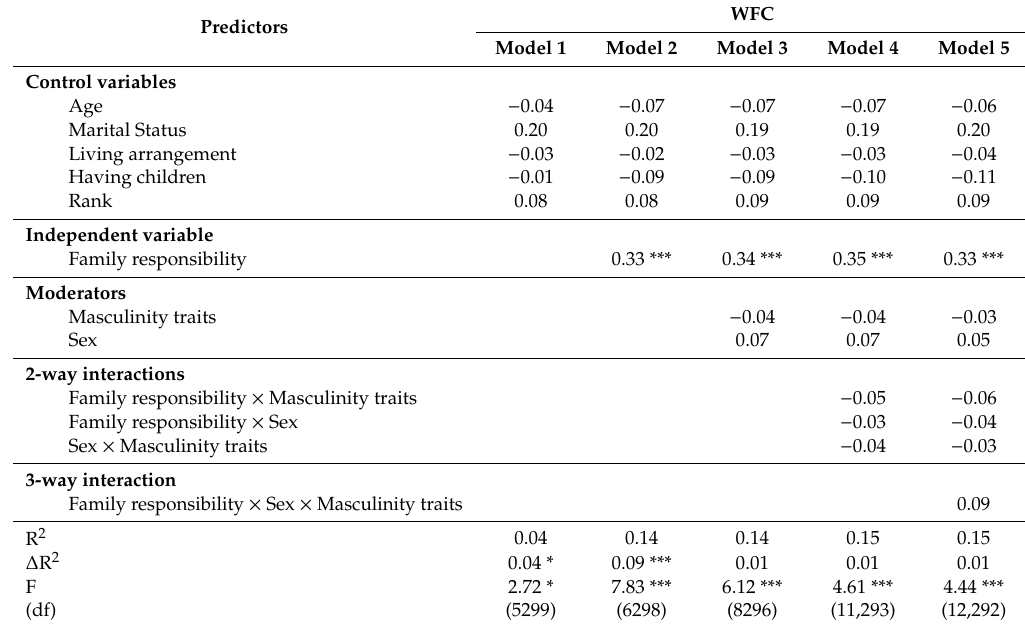
Table 4. Results of moderated regression on work-to-family conflict (WFC): masculinity traits.